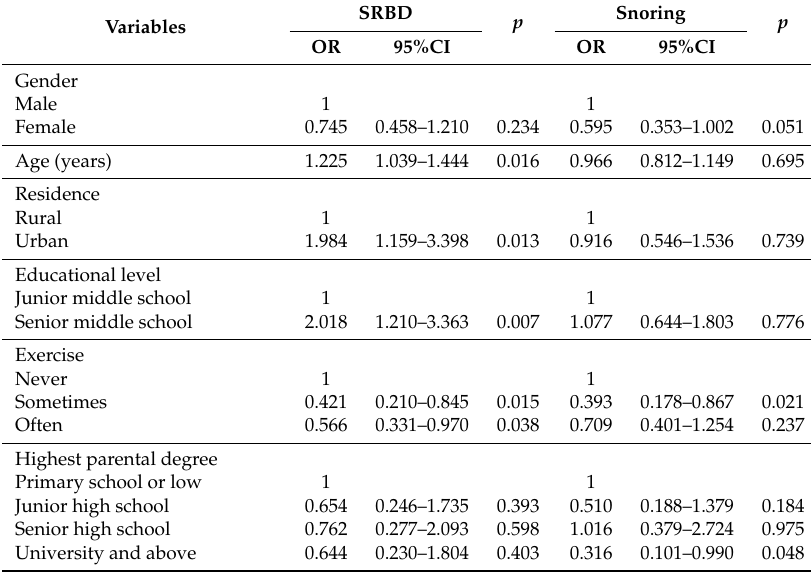
Table 3. Univariate logistic regression analyses on the influencing factors for SRBD and